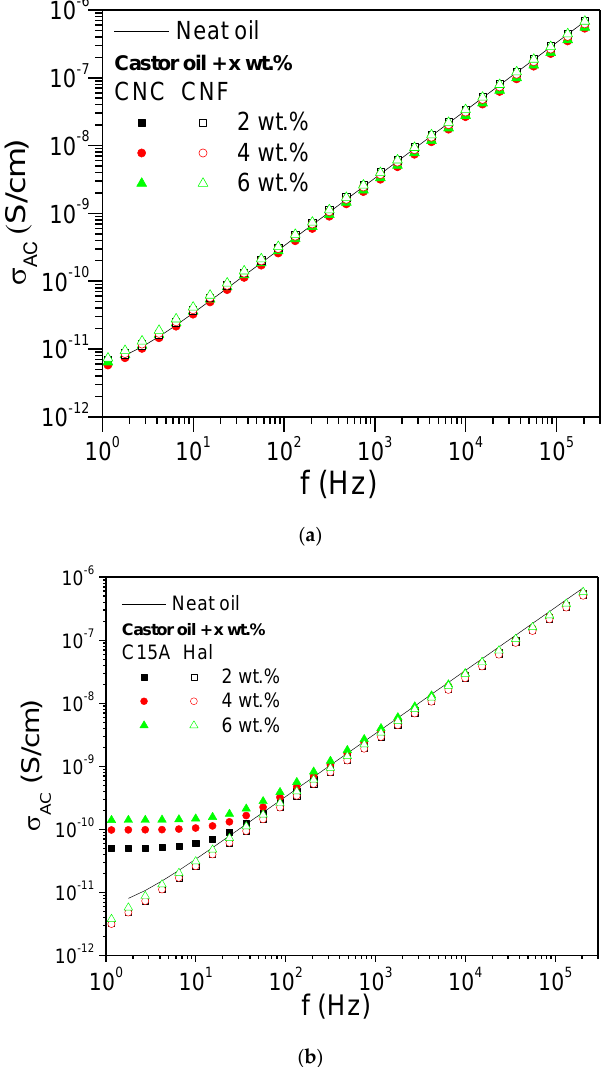
Figure 4. Frequency dependence of the AC conductivity, σ AC , at 25 °C for ( a ) the nanocelluloses and ( b ) the nanoclays dispersions in castor oil, as a function of their concentration.